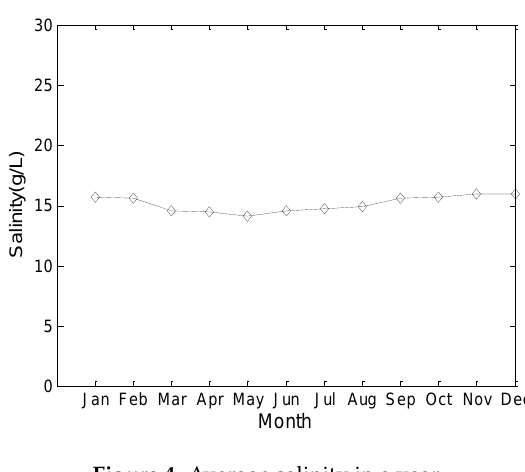
Figure 3. Average temperature in a year.